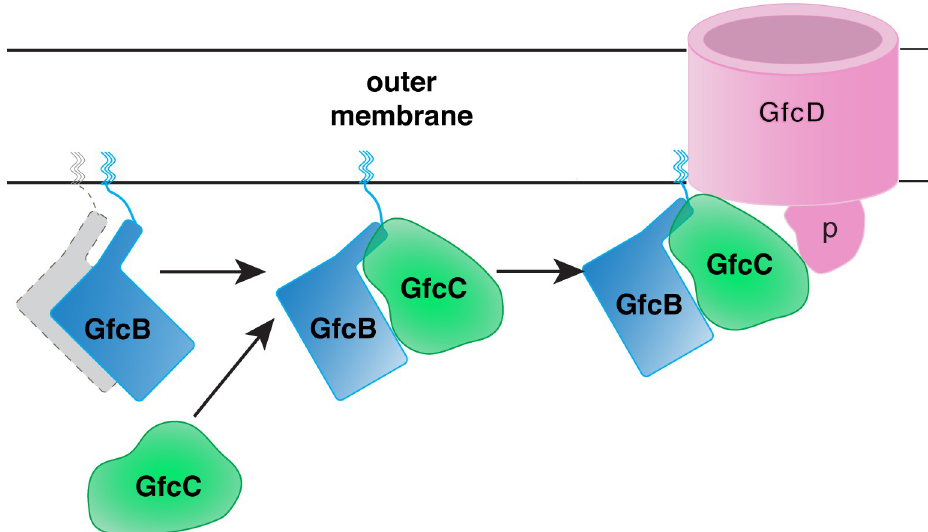
Fig 6. Possible scheme for the formation of the GfcB-GfcC heterodimer and complex with GfcD. The lipoprotein GfcB (possibly a dimer based on PDB entry 2IN5 and the crosslinking experiment in Fig 5A) is anchored to the inner leaflet of the outer membrane and forms a heterodimer with GfcC before binding to GfcD as suggested by the experiment shown in Fig 5A and the relative binding affinities to GfcD (Fig 5C). Domain labeled p is the predicted periplasmic domain of GfcD (see also S3 Fig) which may make interactions with GfcC and/or GfcB, and/or gate the opening of the GfcD barrel.